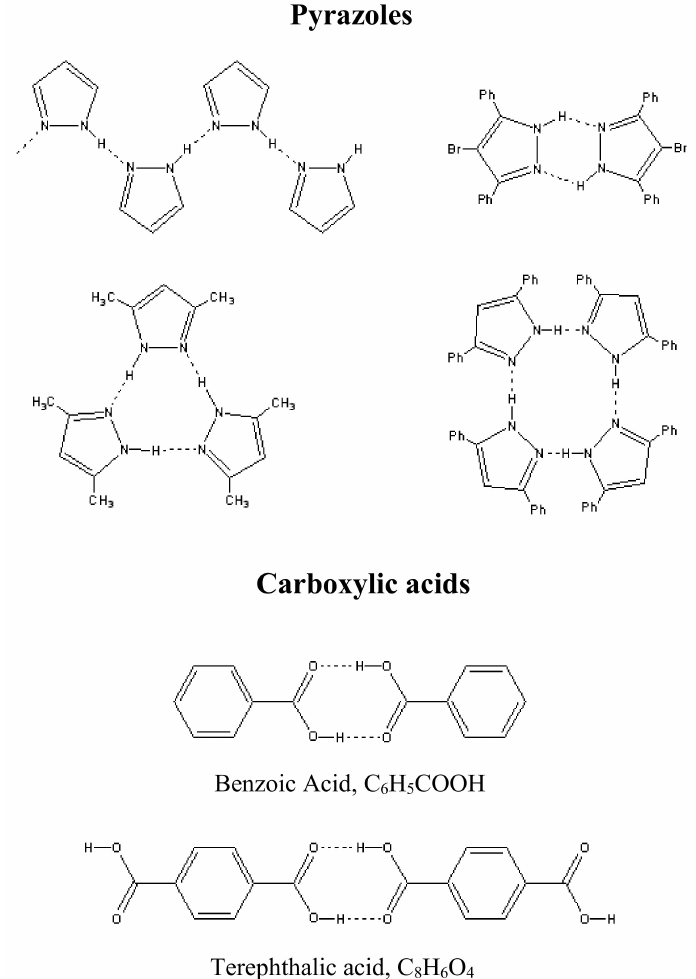
Figure 25. An example of compounds with τ